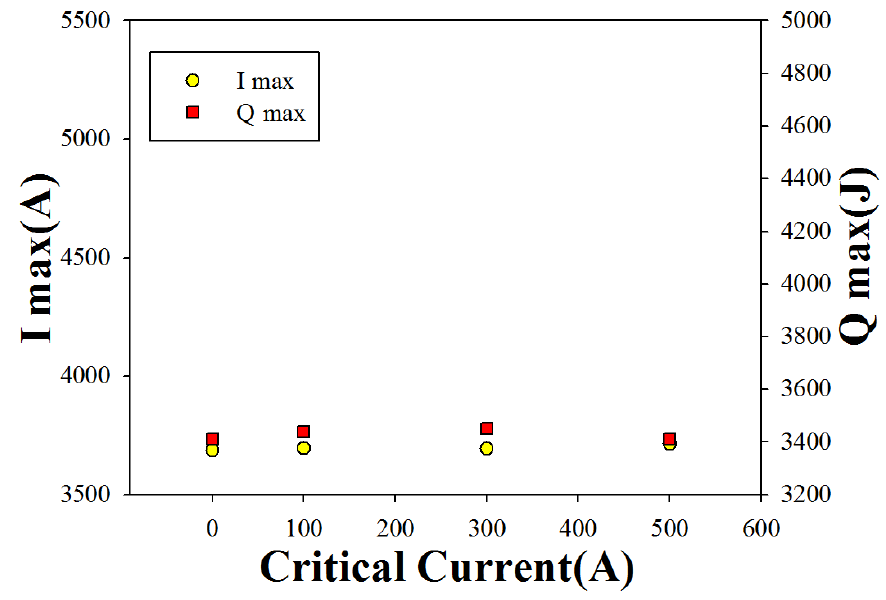
Figure 10. Impact tolerance performance of samples 1–4.